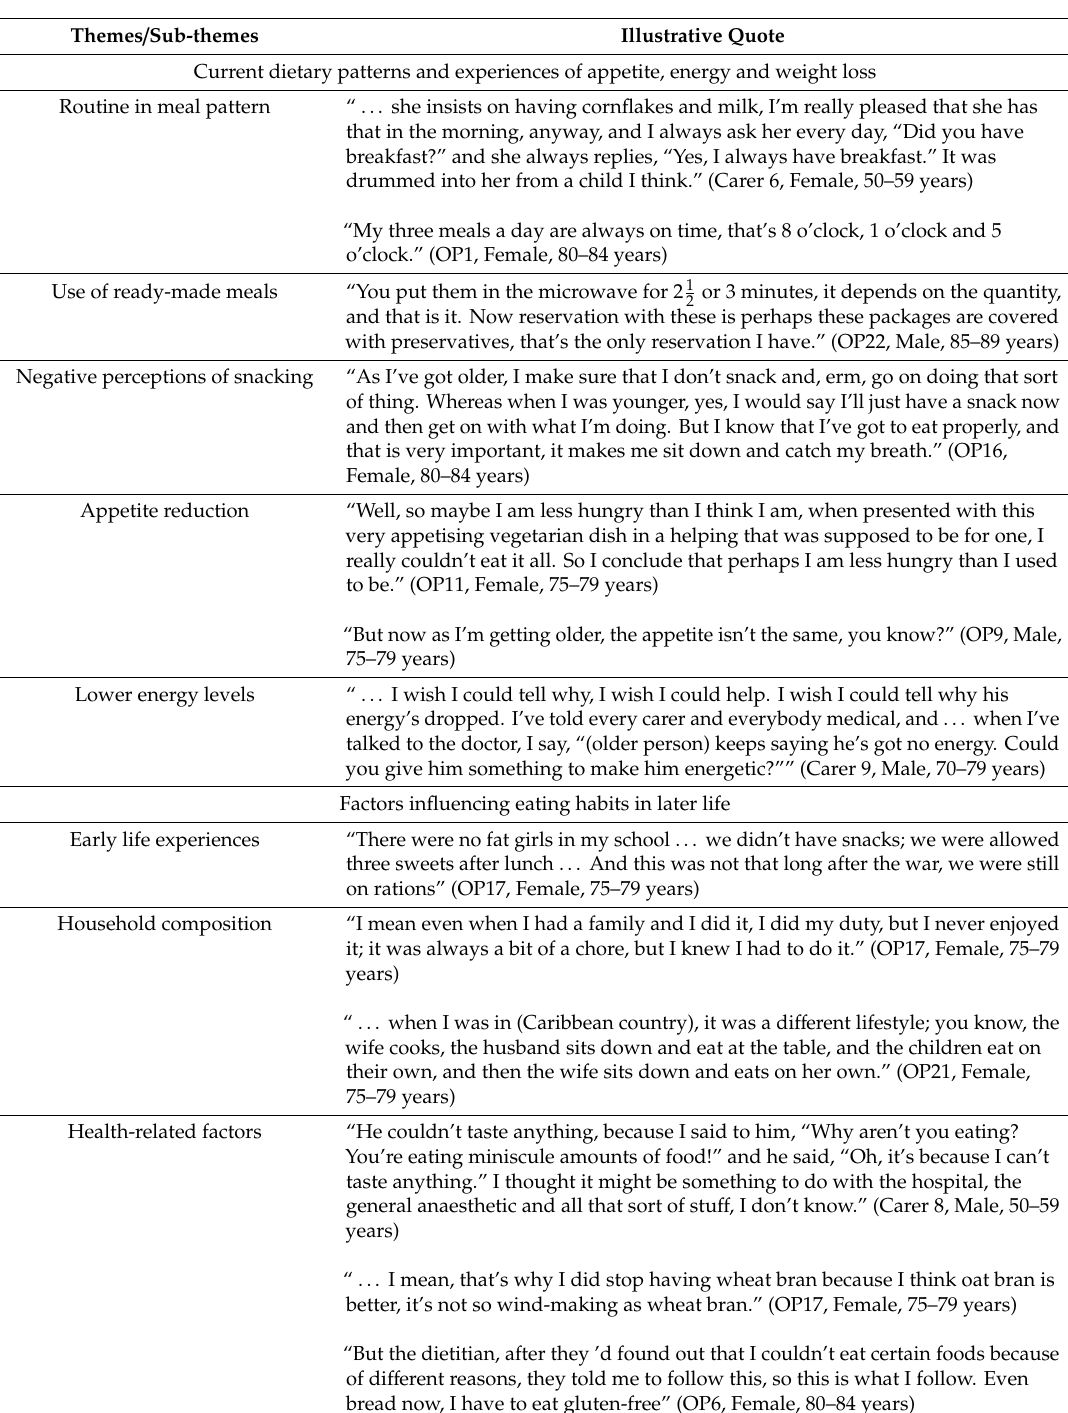
Table 3. Themes and illustrative